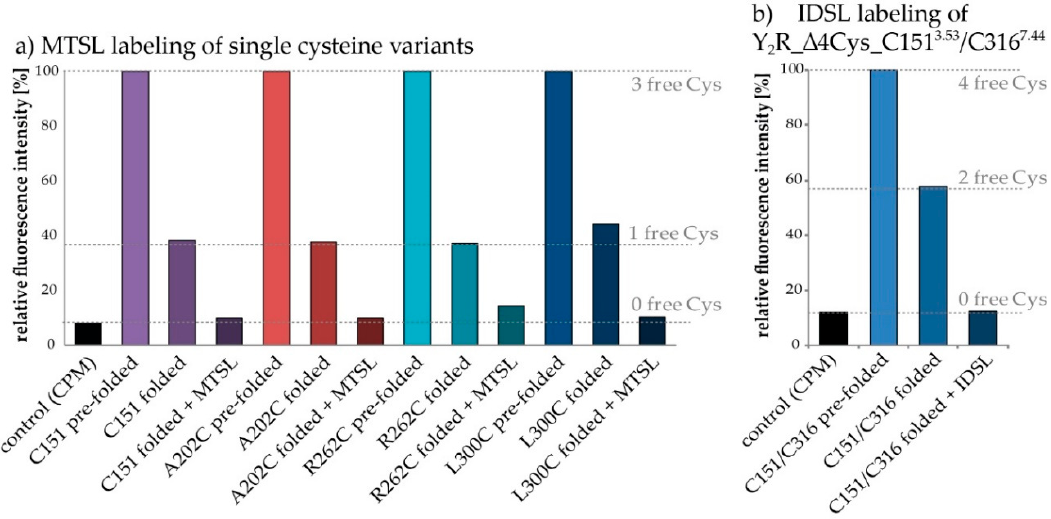
Figure 5. Verification of disulfide bridge formation and nitroxide spin labeling by CPM-Assay: Quantification of free cysteines relies on a thiol-reactive fluorescent probe (CPM), which is essentially non-fluorescentuntilitreactswithfreethiols. Thedashedlinesindicatetheexpectedrelativefluorescence intensity from the number of free cysteines in the respective sample, adjusted to correct for the di ff erence of the signals detected for pre-folded samples (set to 100%) and the control. The pre-folded receptor variants in ( a ) contain three free cysteines, whereas the folded ones have one remaining free Cys. The decrease in fluorescence intensities in all Y 2 R-variants illustrates the completeness of disulfide bridge formation. Furthermore, the spin labeled variants (no free Cys) generate the same weak fluorescence intensity as the control sample, which is an indication of an e ff ective reaction with the spin label. In ( b ) the normalized fluorescence intensity of the cysteine double mutant Y 2 R_ ∆ 4Cys_C151 3.53 / C316 7.44